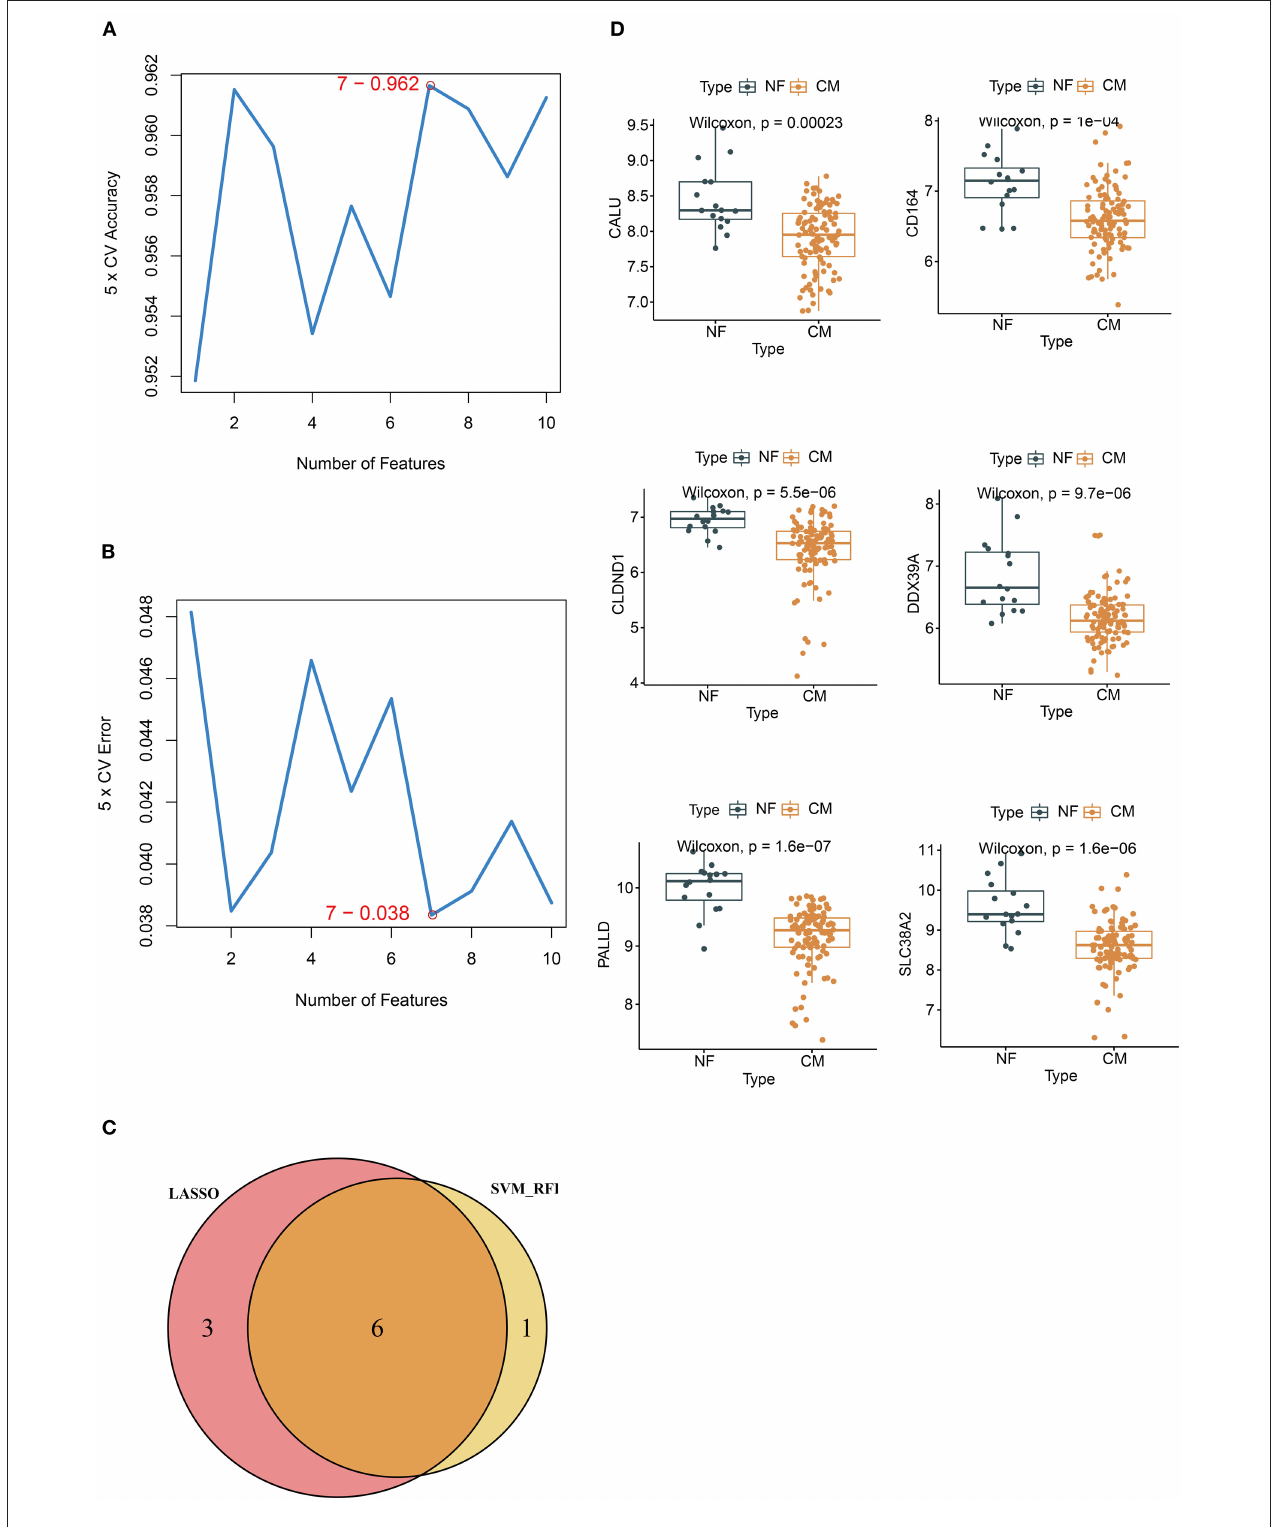
FIGURE 5 | Identification of candidate genes by SVM-RFE. (A) 7 gene signatures are identified by SVM-RFE analysis with the accuracy of 0.962 and (B) error of 0.038. (C) Venn diagram of six overlapped candidate genes shared by the LASSO and SVM-RFE algorithms. (D) The expressions of candidate diagnostic biomarkers in the NF and CM samples from GSE5406